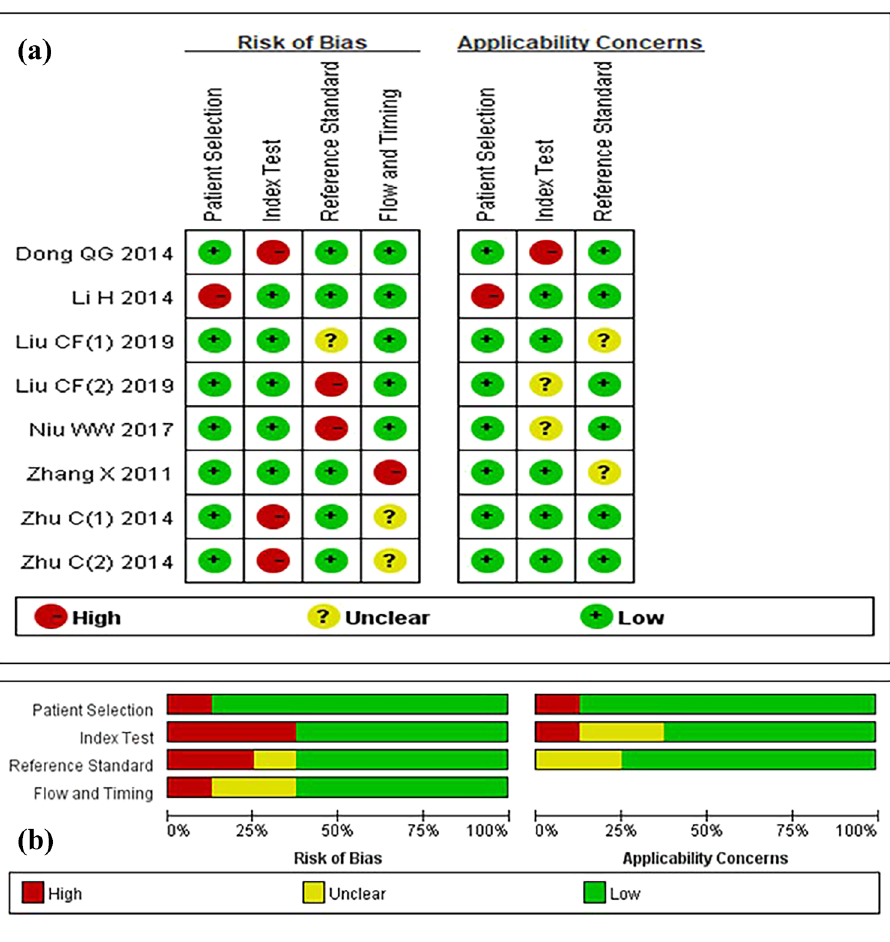
Figure 2: QUADAS - 2 quality assessment. Investigators ’ assessment regarding each domain for included studies: ( a ) graph and ( b ) summary.